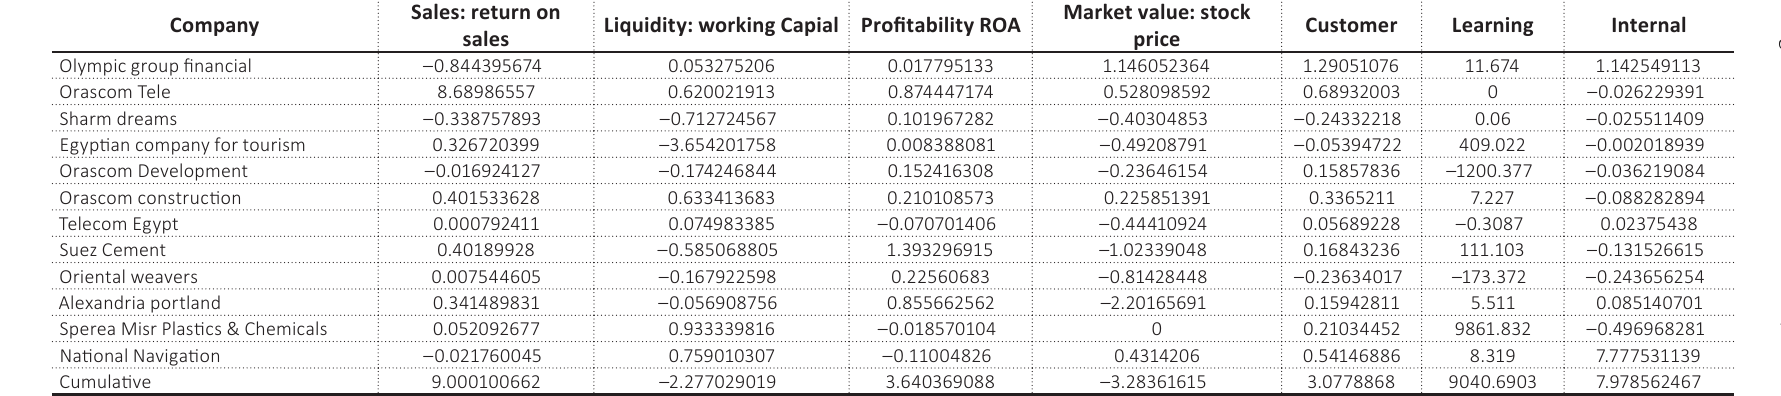
Table B1. Differential analysis for post- and pre-M&A BSC perspectives